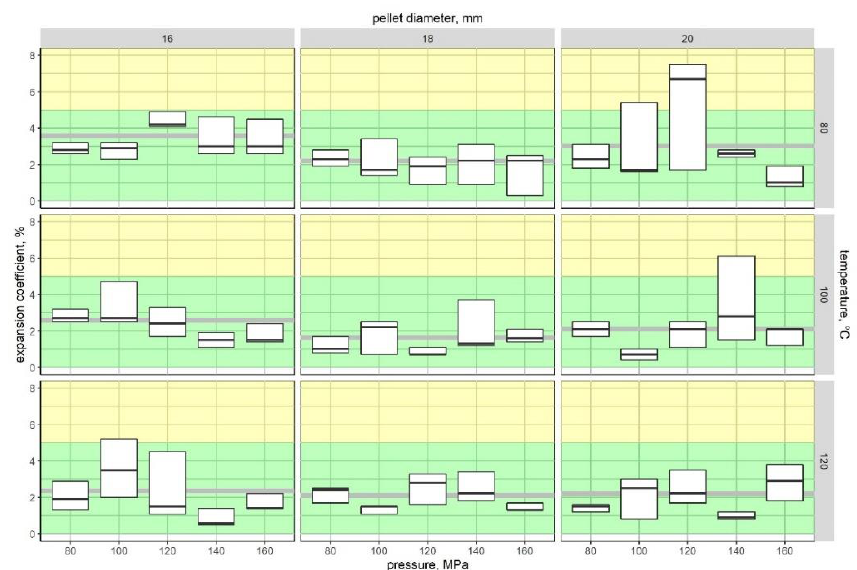
Figure 10. Pellet quality criterion based on the expansion coefficient.